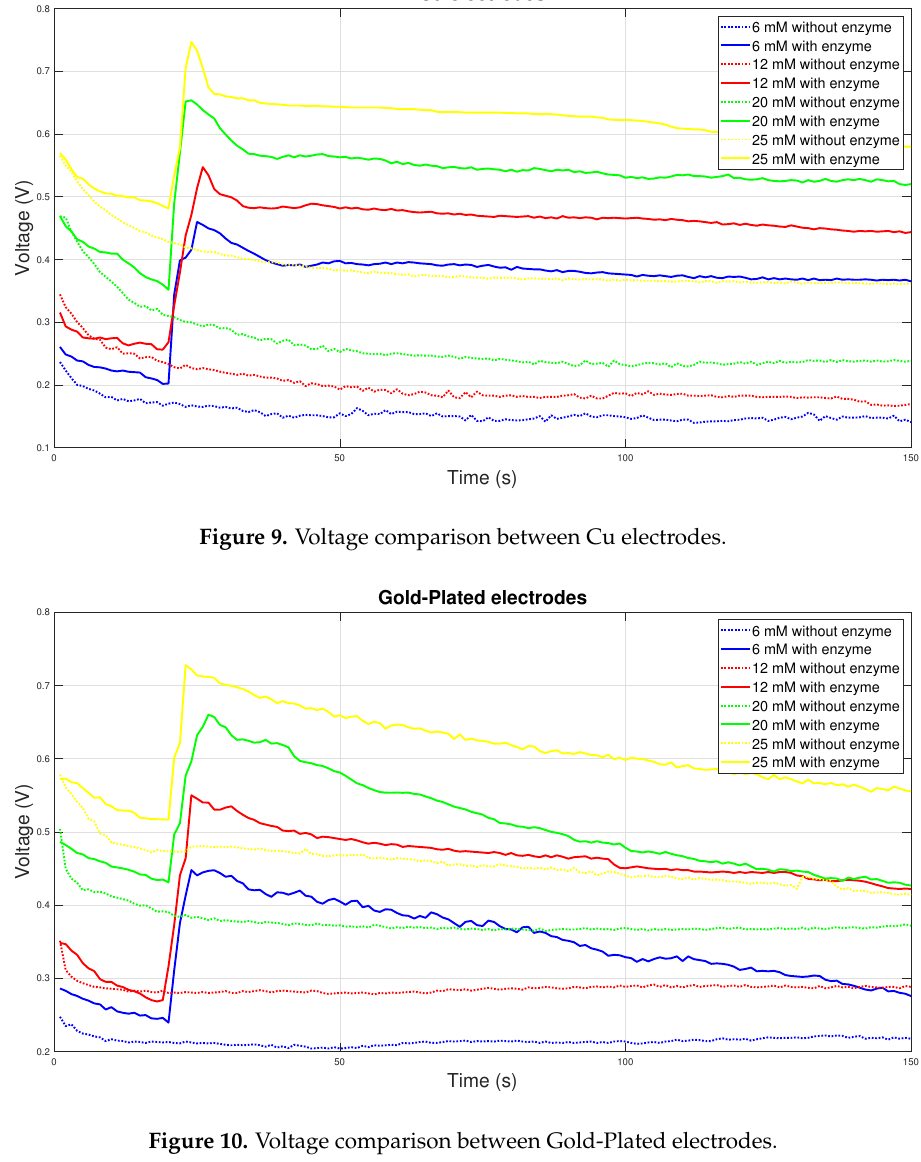
Figure 10. Voltage comparison between Gold-Plated